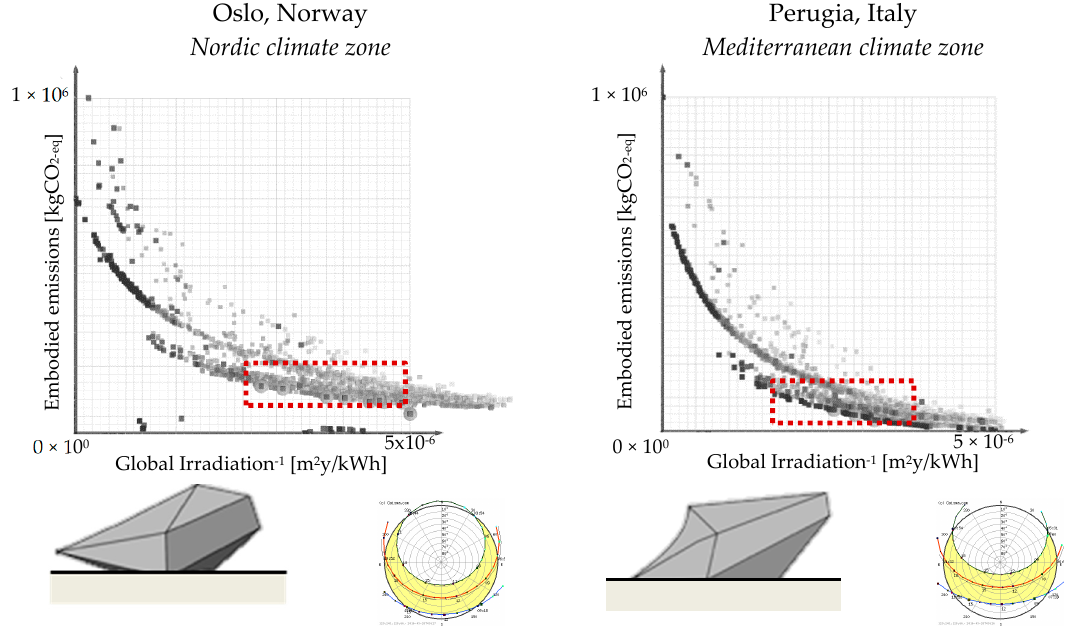
Figure 3. Step 3 —graphical representation of the outcomes of the multi-objective optimization.